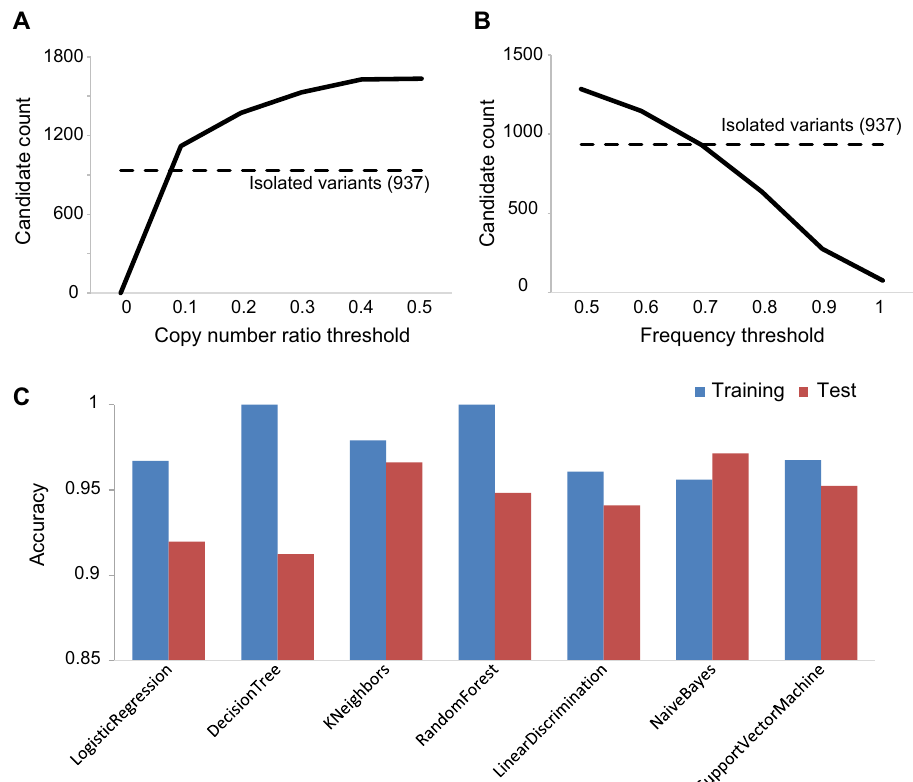
Figure 6. Machine learning to filter false-positive candidates. ( A , B ) In the general copy number analysis of WGS data, the copy number ratio value (Supplementary Fig. S4) is used for indicator of deletions, and the frequency of a variant is used for the criterion whether it is homozygous or not. From the detected candidate variants, we counted the number of them with lower than a certain value of the normalized depth ( A ), and the number of them with higher than a certain value of the frequency ( B ). The broken line shows the number of isolated homozygous variants. ( C ) For the selection of variants by machine learning, we tested 7 algorithms, logistic regression (LR), decision tree (DT), k-nearest neighbor (kNN), random forest (RF), linear discrimination (LDA), naïve Bayes (NB), and support vector machine (SVM). We used the data listed in Supplementary Table S5 for the training and Table S9 for the test. After the training, we checked the accuracy of prediction whether the candidate is true or false using each learned model. The result of prediction to training data (blue bar) and test data (red bar) was shown. The analysis was performed using our original script (https:// github. com/ YujiS ue/ python/ blob/ master/ Delet ionFi lter.